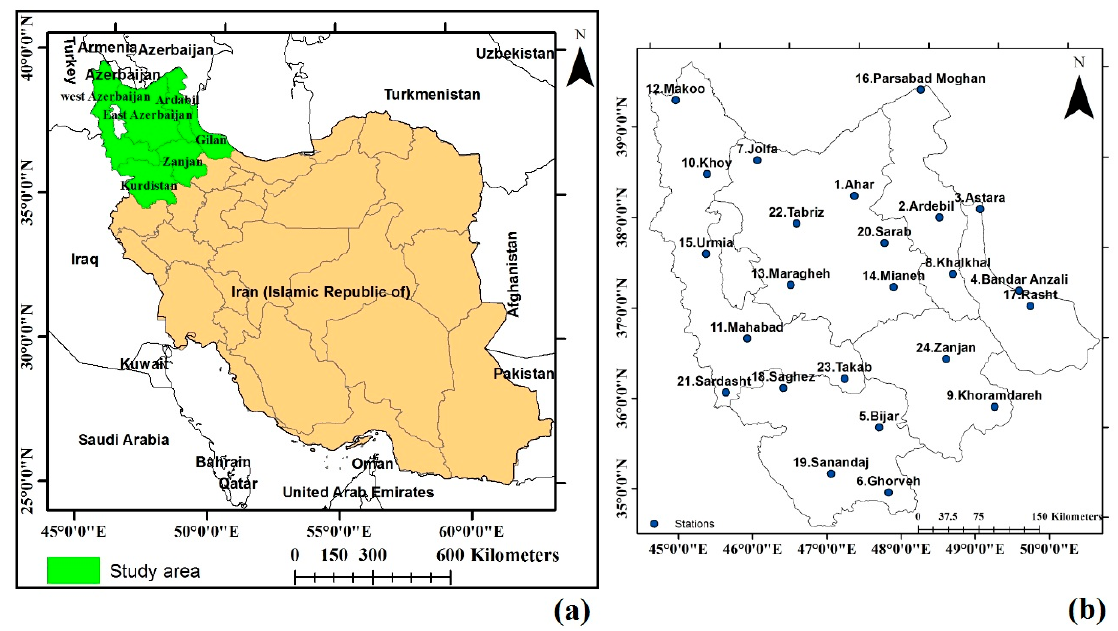
Figure 1. ( a ) The geographic location of the study area; and ( b ) the weather stations used in this study.